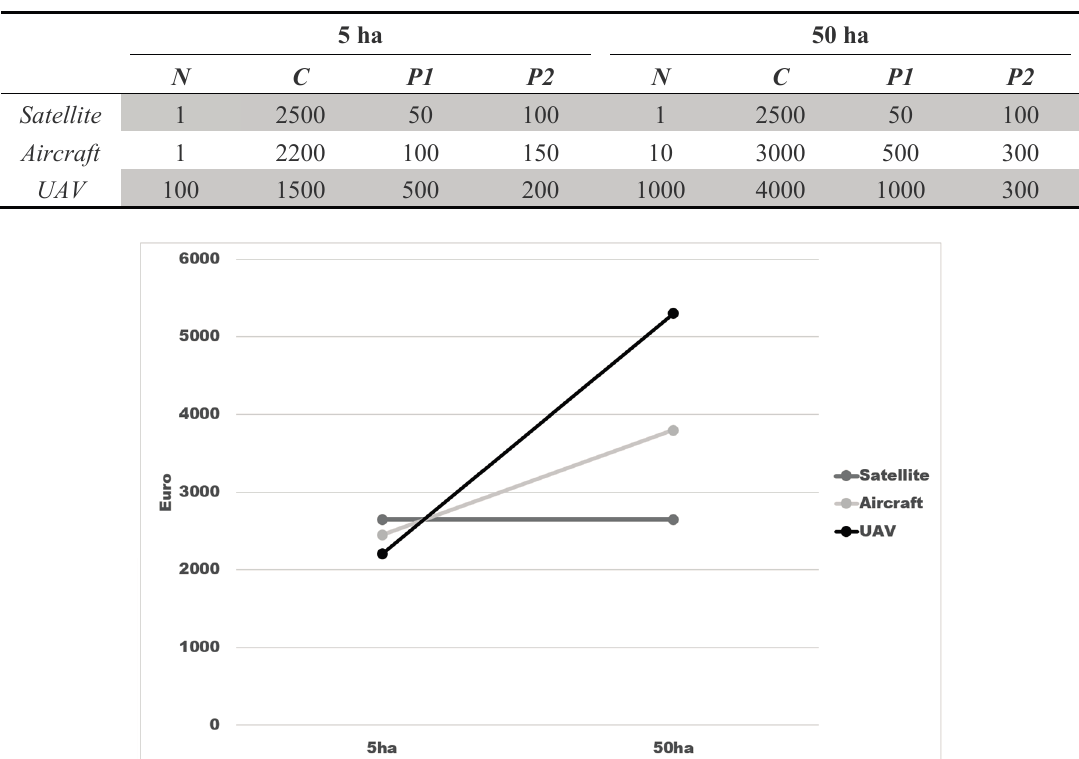
Figure 7. Plot of category costs (Euro) for satellite, aircraft and UAV platform, considering a 5 ha and 50 ha mapping